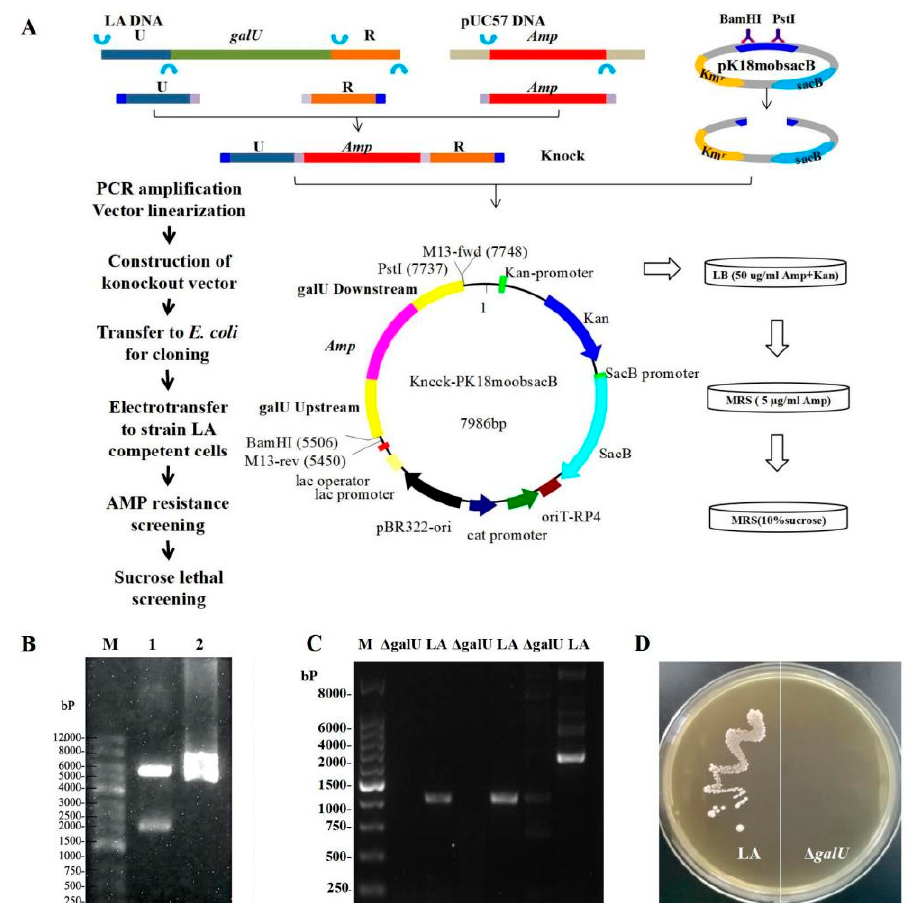
Figure 1. Schematics and results for the knockout of the galU gene. ( A ) Schematics for the knockout of the galU gene. ( B ) BamHI-PstI double-digestion map. Lane M, Marker 12,000 bp; Lane 1, fragments of the digested plasmid, Lane2, recombinant plasmid Knock-pK18mobsacB. ( C ) PCR amplification of the knockout strain ∆ galU and original LA strain. Lane M, Marker 8000 bp; ∆ galU , PCR amplification of the knockout strain ∆ galU ; LA, PCR amplification of the original LA strain. ( D ) The growth of the original strain LA and knockout strain ∆ galU on an M17 plate, with lactose as the sole glycogen. The left side of the plate is the original strain LA, which can form normal colonies. The right side of the plate is the knockout strain, ∆ galU , without colony formation.